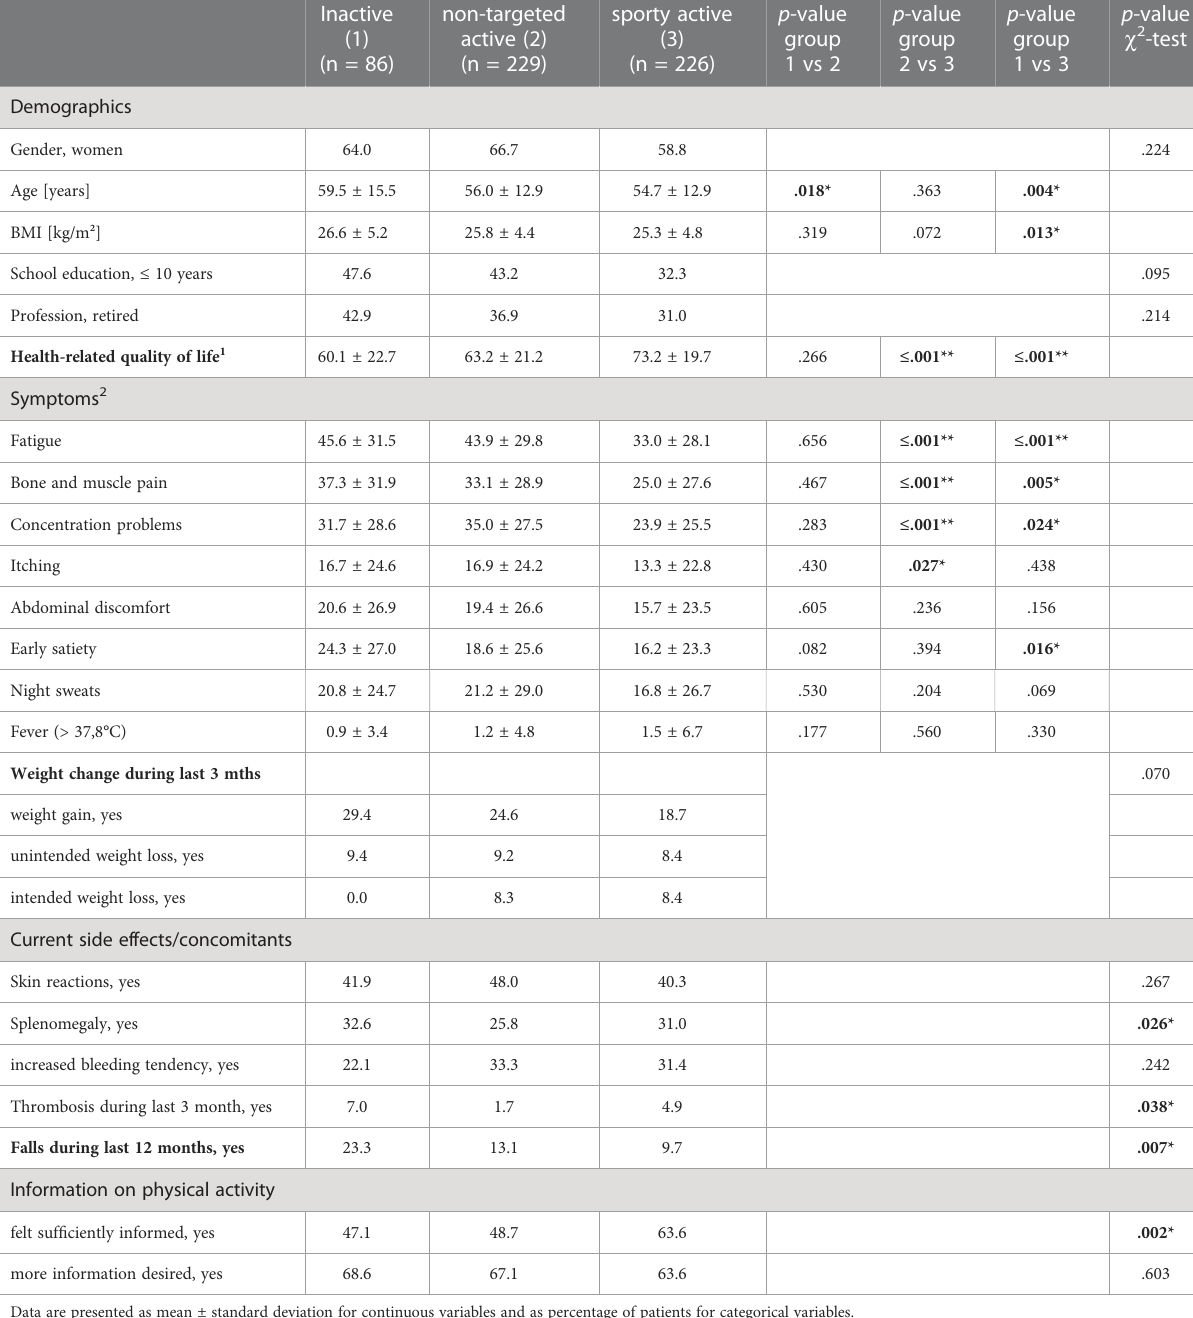
TABLE 3 Characteristics of patients with myeloproliferative neoplasms depending on the level of physical